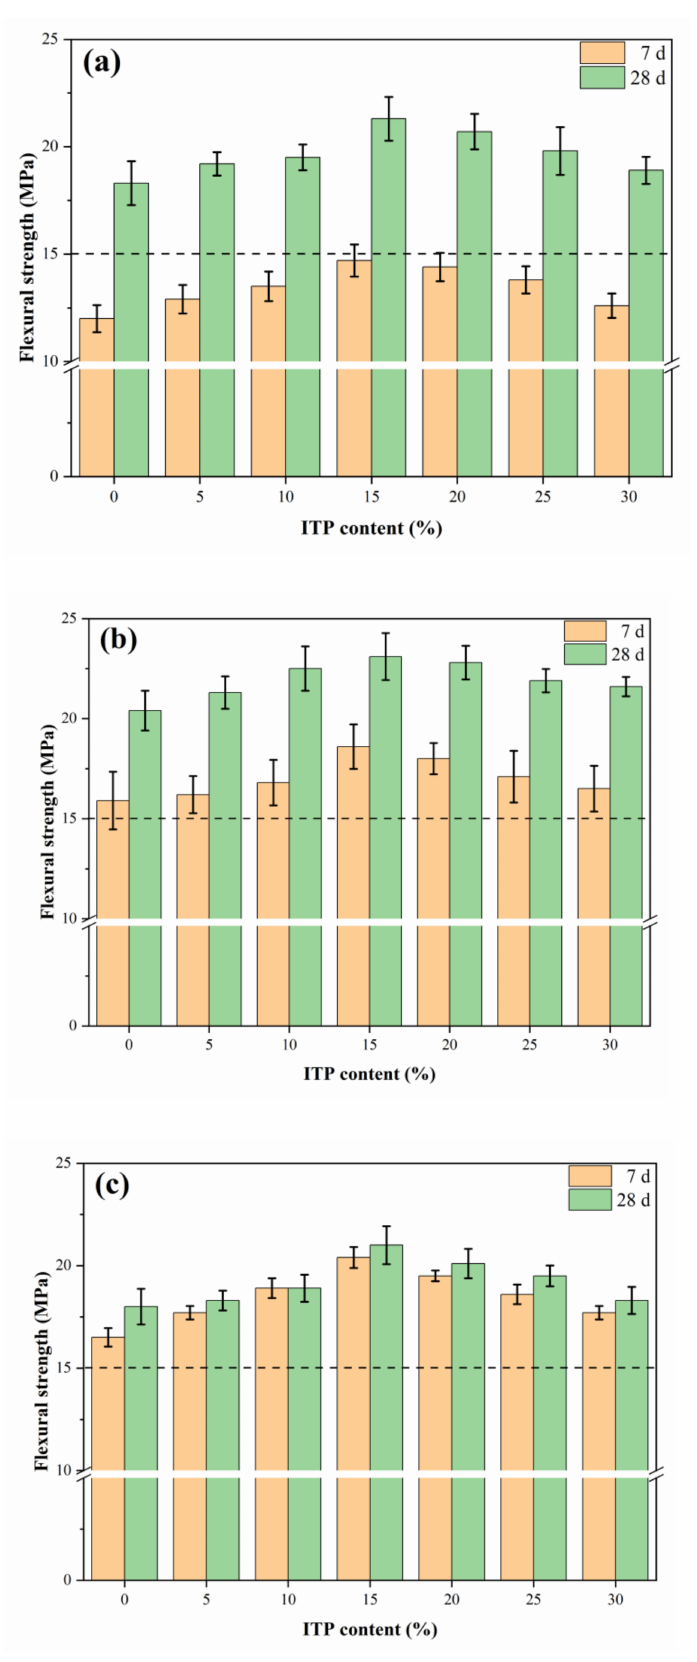
Figure 4. Flexural strength of samples containing ITP under ( a ) standard curing, ( b ) warm-water curing; and ( c ) steam